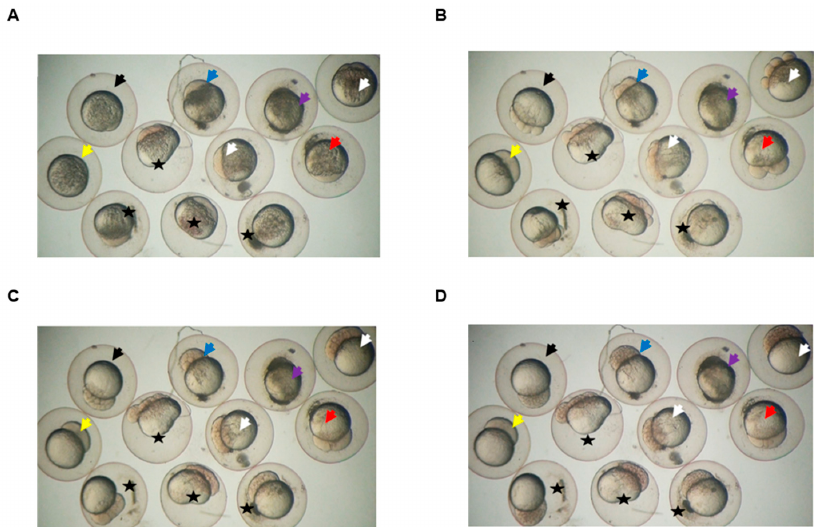
Figure 8. Klotho knockdown causes cleavage defects in zebrafish embryos. Images were captured from live video (Supplemental Movie 5) of wild type zebrafish embryos without any treatment (uninjected, black arrow) or after injection with dye (mock, blue arrow), or dye plus Klotho- morpholino. Most of the Klotho-morpholino-injected embryos displayed defective phenotypes, including no cleavage (yellow arrow), cleavage stopped at two cells (red arrow), and asymmetrical cleavages (stars). Some embryos died (purple arrow), and others developed normally (white arrow). ( A ): One to two cells stage; ( B ): four to eight cells stage; ( C ): 32 to 64 cells stage; and ( D ): around 128 cells stage.